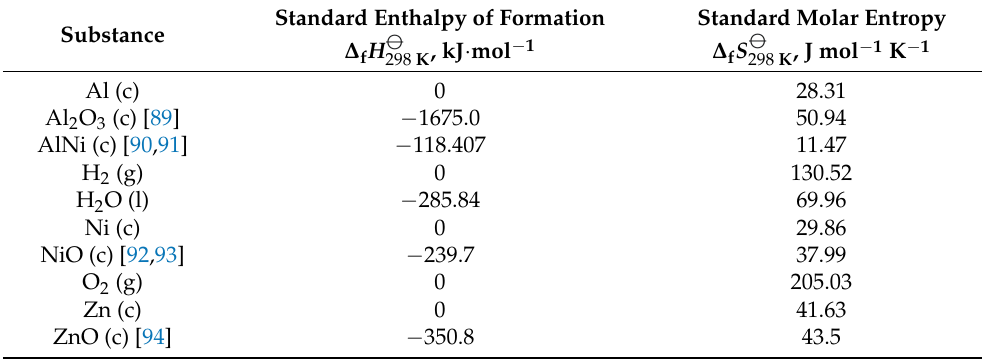
Table 5. Enthalpy and molar entropy for some substances at 298 K [88]. Table 15. Calculated entropy of some Ni-containing substances and equilibrium temperatures.